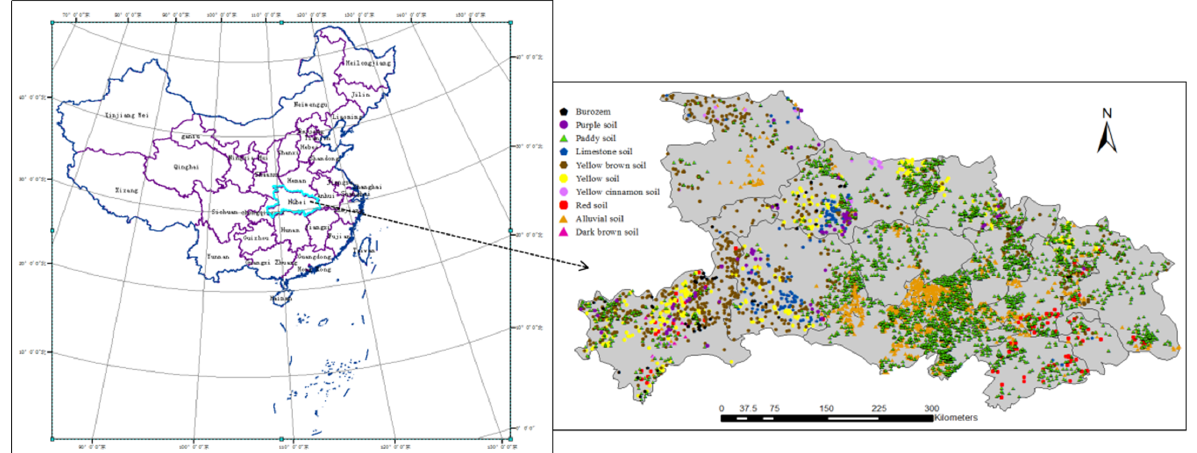
Figure 1. Locations of sampling sites in the study area and their soil types.